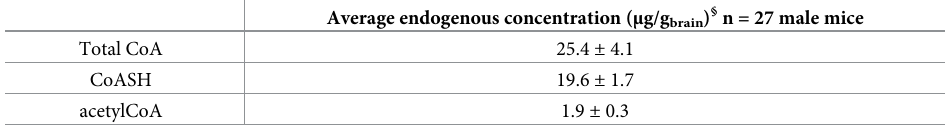
Table 5. Average endogenous level of unlabelled free CoA (CoASH), acetylCoA and total CoA in male C57/Bl6 mouse brain (n = 27) during the intrastriatal infusion study over a period of 336 h after dosing.